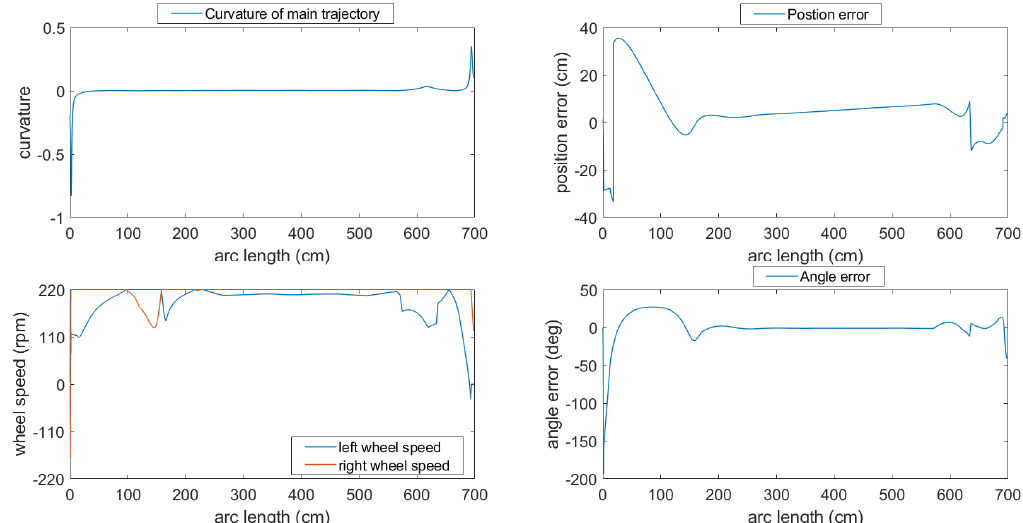
Figure 22. Left and right wheel angular speed, position error and heading error of the robot’s pose, with respect to desired pose on trajectory of the second scenario.